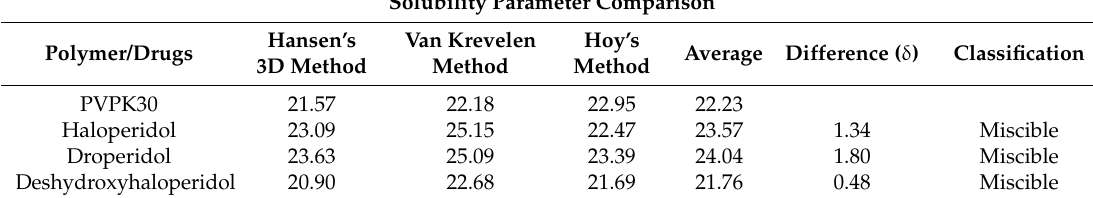
Table 1. The solubility parameters and solubility parameter differences ( δ ) of PVPK30 and the three studied molecules. The solubility parameters were used in predicting the polymer/drugs